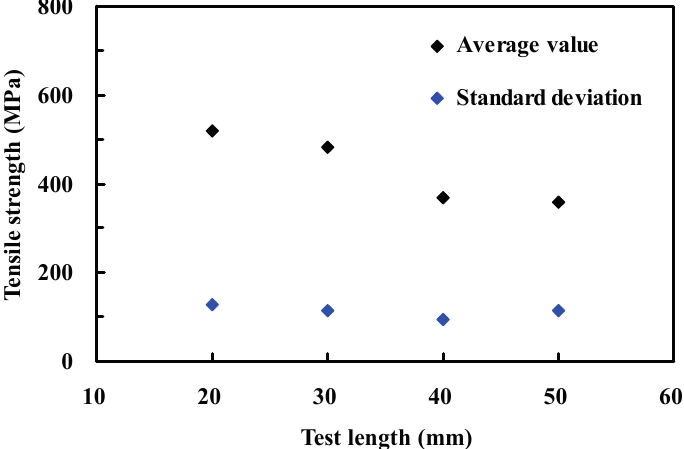
Figure 5. Dependence of the tensile strength of bamboo fiber on the test